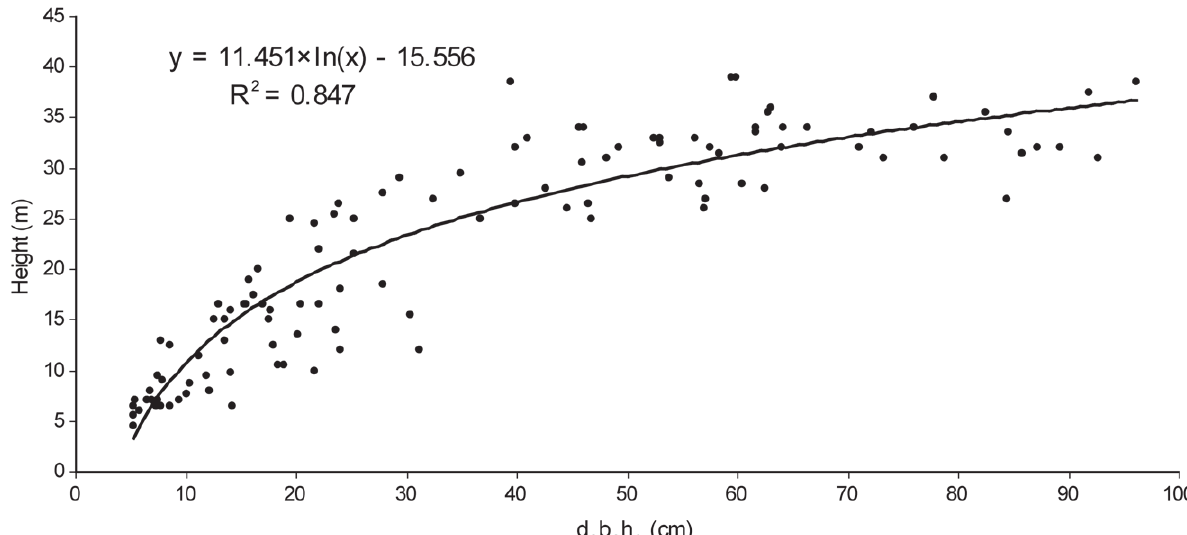
Figure 5. Spatial distribution of live trees in the Kopa (A) and Gorjanci (B) forest reserves. The bold line represents the theoretical (random) distribution of trees.